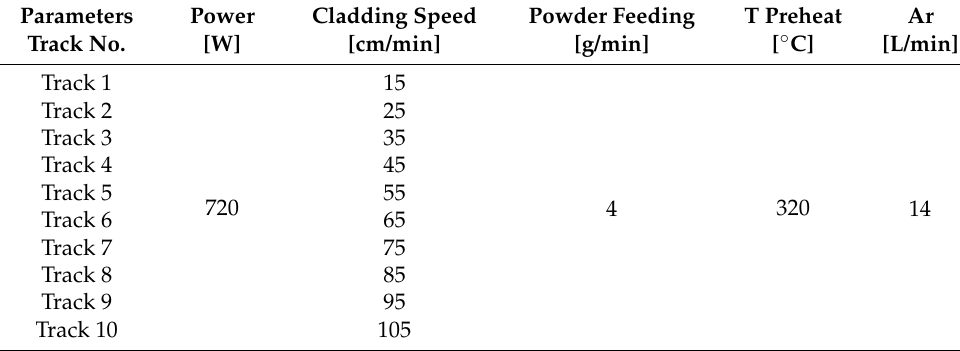
Table 2. Cladding parameters for individual